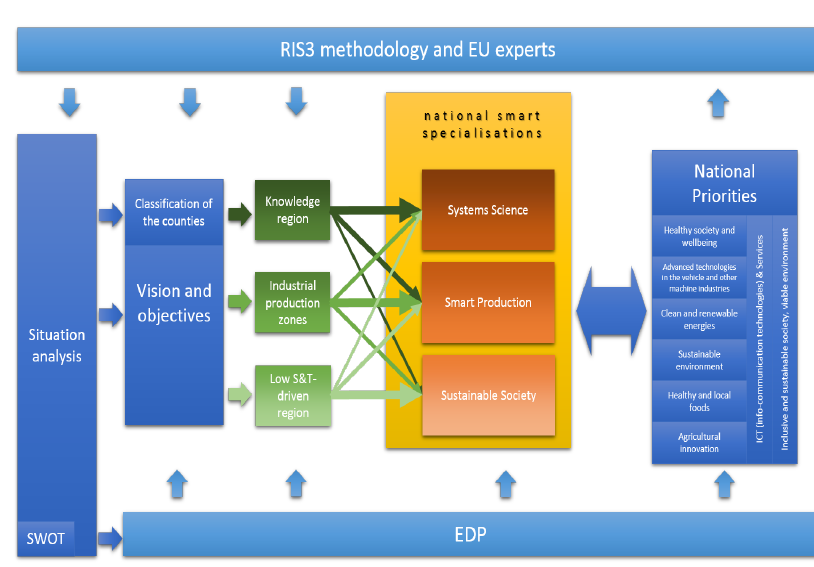
Fig 1. The Hungarian smart specializations and national priorities Table 3. Summary of the systems science, smart production and sustainable society Systems